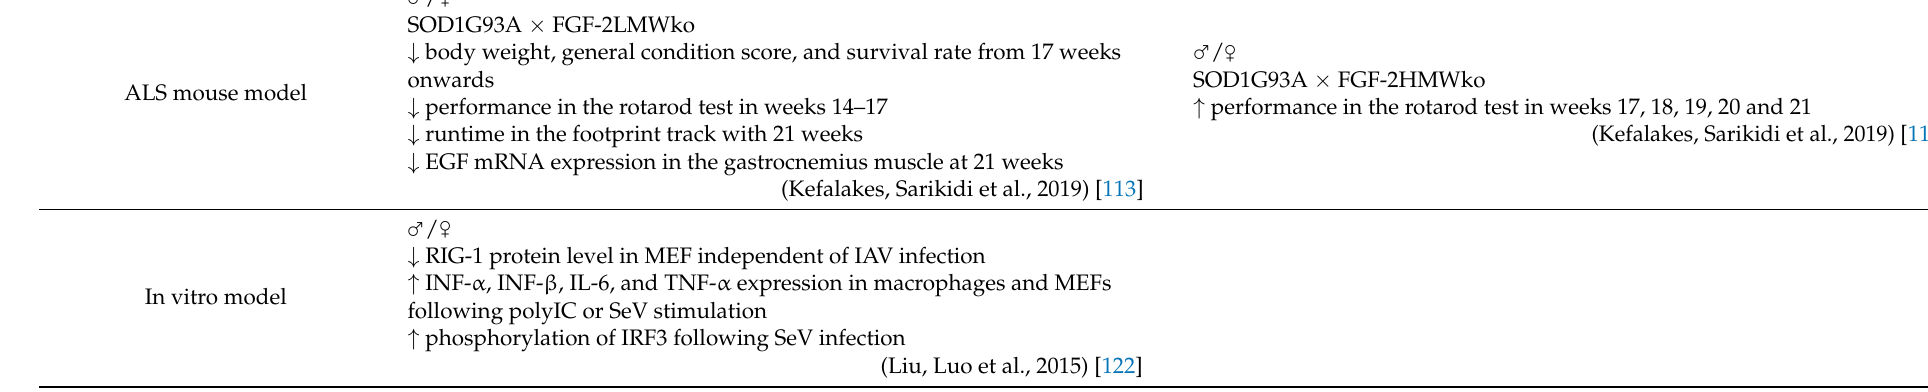
Table 3. In vivo alterations in the central nervous system of male ( ) and female ( ) FGF-2 isoform-specific knock out mice, lacking either FGF-2LMW (FGF-2LMWko) or FGF-2HMW ♀ ♂ (FGF-2HMWko) shown as increased ( ↑ ) or decreased ( ↓ ) compared to wildtype littermates. Additionally, in vitro data were provided, characterizing the participation of FGF-2LMW in the innate immune response by using FGF-2LMWko derived embryonic fibroblasts (MEF). ALS, amyotrophic lateral sclerosis; E14, embryonic day 14; DA, dopaminergic; EGF, epidermal growth factor; FGF-2, fibroblast growth factor 2; HMW, high molecular weight; IAV, influenza A virus; IL-6, interleukin 6; INF- α , interferon α ; INF- β , interferon β ; IRF3, interferon regulatory factor 3; LWW, low molecular weight; ko, knock out; MEF, mouse embryonic fibroblasts; P0, day of birth; polyIC, polynosinic-polycytidylic acid; RIG-1, retinoic acid inducible gene I; SeV, sendai virus; SNpc, substantia nigra pars compacta; SOD1G93A, superoxide dismutase 1 with a mutation on residue 93; TNF- α , tumor necrosis factor α . FGF-2 LMWko Strain (FGF-2 tm2Doe ) / ♀ ↑ FGF-2LMW protein in brain tissue ♂ (Azhar, Yin et al., 2009) [43] / ♀ ↑ FGF-2LMW protein expression in the nigrostriatal pathway from P0 ♂ through development ↑ number of DA precursor cells in the rostral subventricular zone at E14.5 ↑ signs of apoptosis in DA neurons of the ventral midbrain at P0 ↑ number of DA neurons in the adult female SNpc ↑ explorative behavior of adult male mice (von Hövel, Leiter et al., 2019) [22]